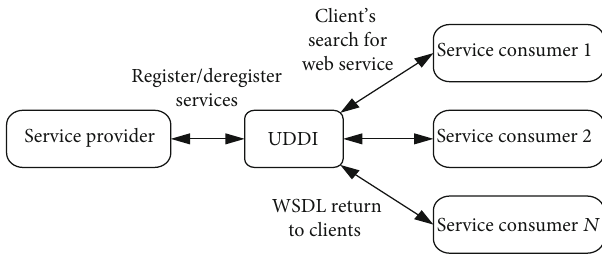
Figure 2: Web service framework.